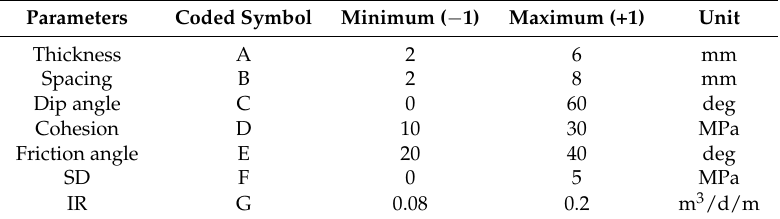
Table 2. Uncertainty parameters of multiple parameter optimizations in this study. SD: stress difference; IR: injection